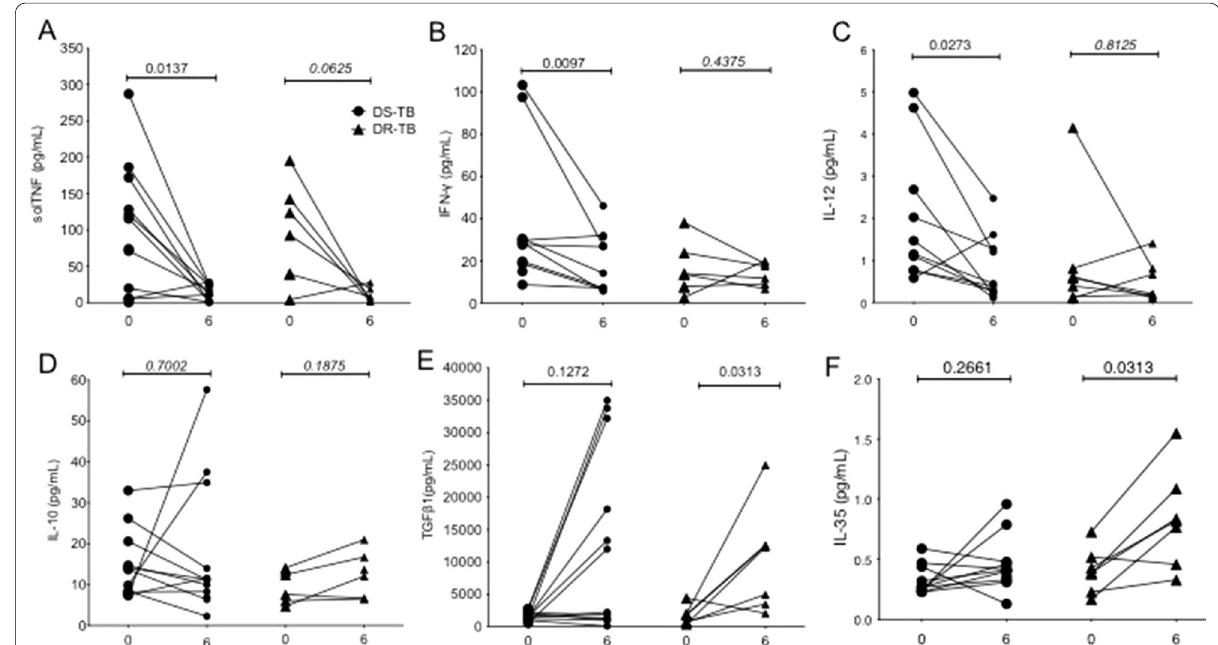
Fig. 5 Pro‑inflammatory cytokines keep increased in the sixth month of anti‑TB therapy in DR‑TB. Levels of cytokines from DS‑TB and DR‑TB patients were measured in plasma at diagnosis time (0) and 6 months (6) of starting the anti‑TB therapy. Pro‑inflammatory cytokines: sTNF ( A ), IFNγ ( B ), and IL‑12 (IL12p70) ( C ), and anti‑inflammatory cytokines: IL‑10 ( D ), TGFβ1 ( E ), and IL‑35 ( F ) were measured. DS‑TB Wilcoxon matched‑pairs test (*p < 0.05)